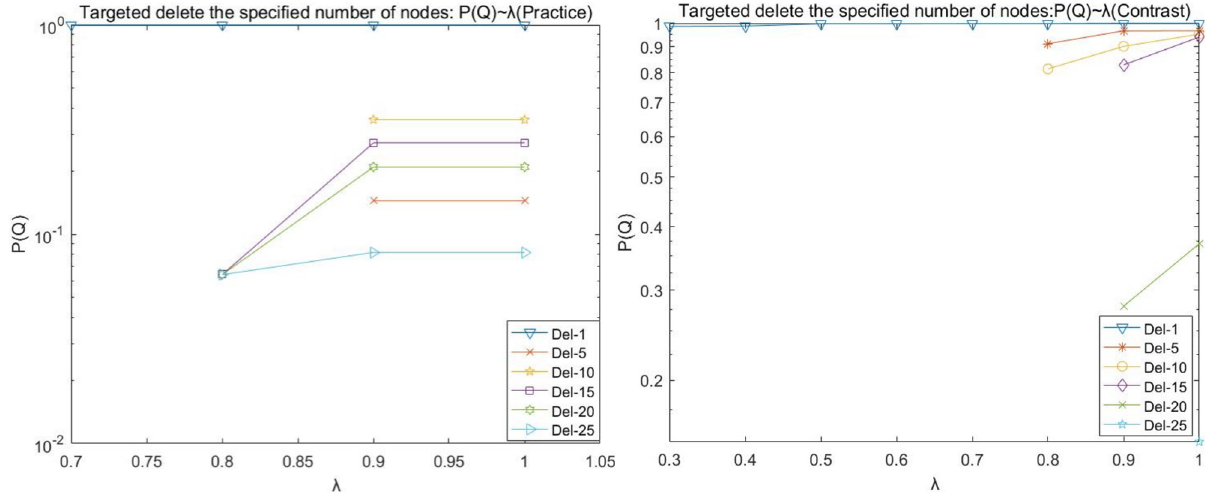
Fig 8. Target disruption- P ( Q ) with λ variation diagram.